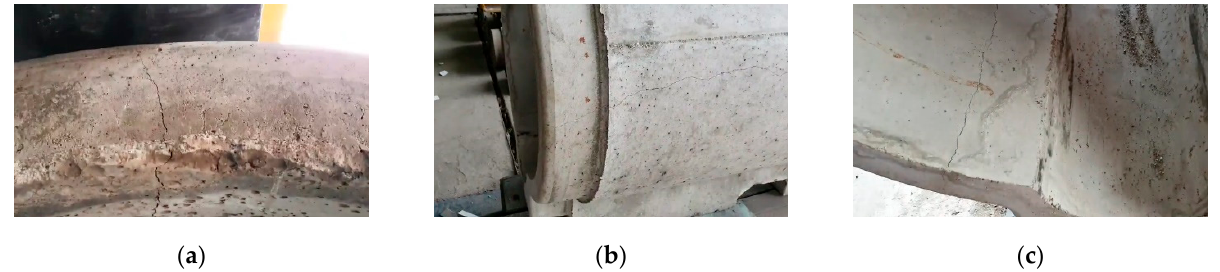
Figure 13. Crack position on a complex cross-section reinforced concrete pipe, ( a ) crown, ( b ) right side (3 o’clock), ( c ) left side (8 o’clock).